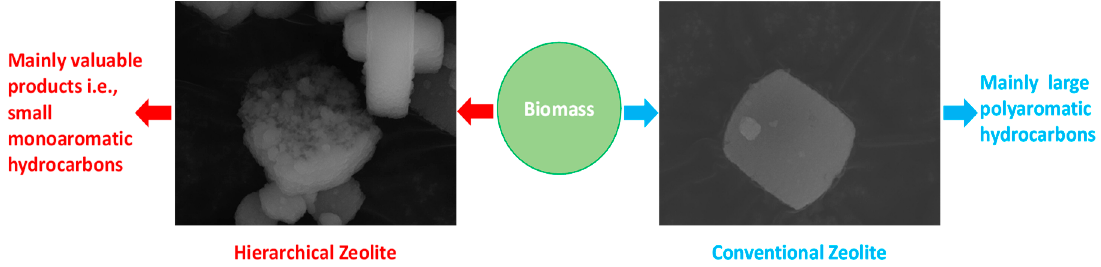
Figure 10. Comparison of the performances of hierarchical zeolite versus conventional zeolite for biomass conversion and pyrolysis.